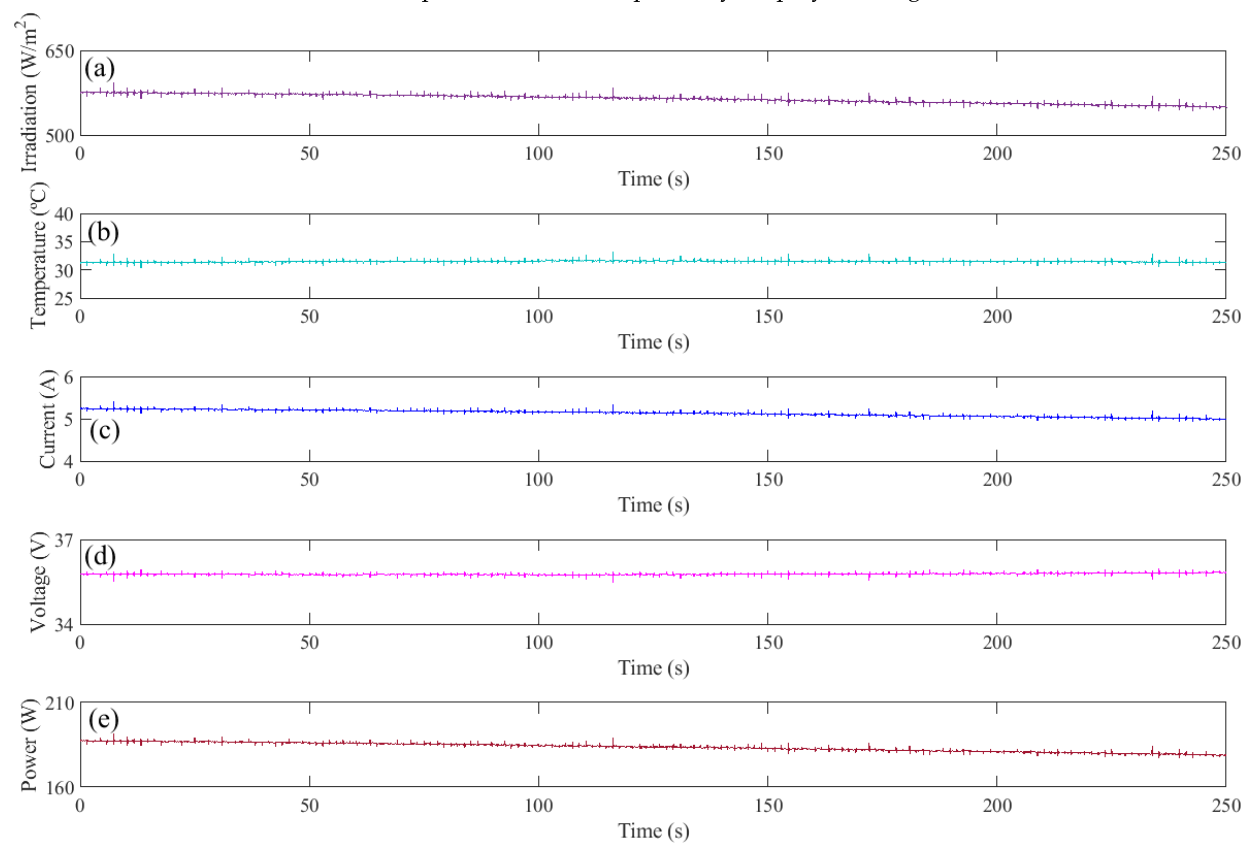
Figure 19. MPPT based on RNN and FLC: ( a ) Irradiation (W/m 2 ); ( b ) Temperature ( ◦ C); ( c ) PV current; ( d ) PV voltage; ( e ) PV